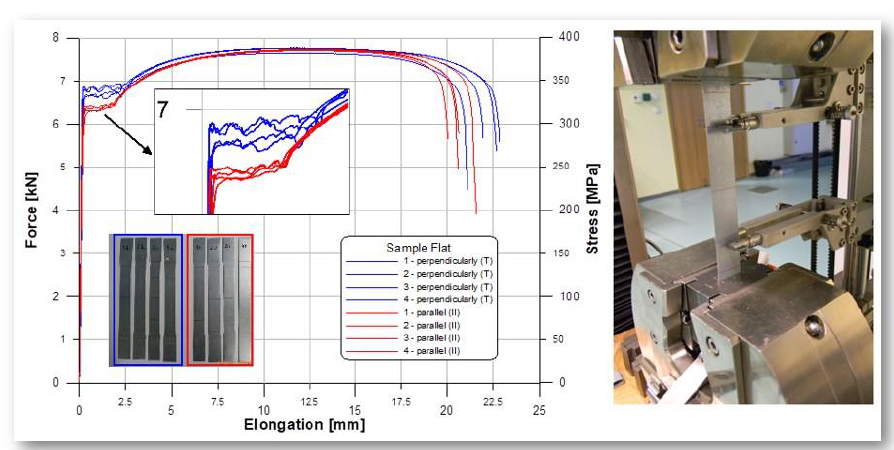
Figure 2. Research on the durability properties of DX51. Table 1. Strength properties of